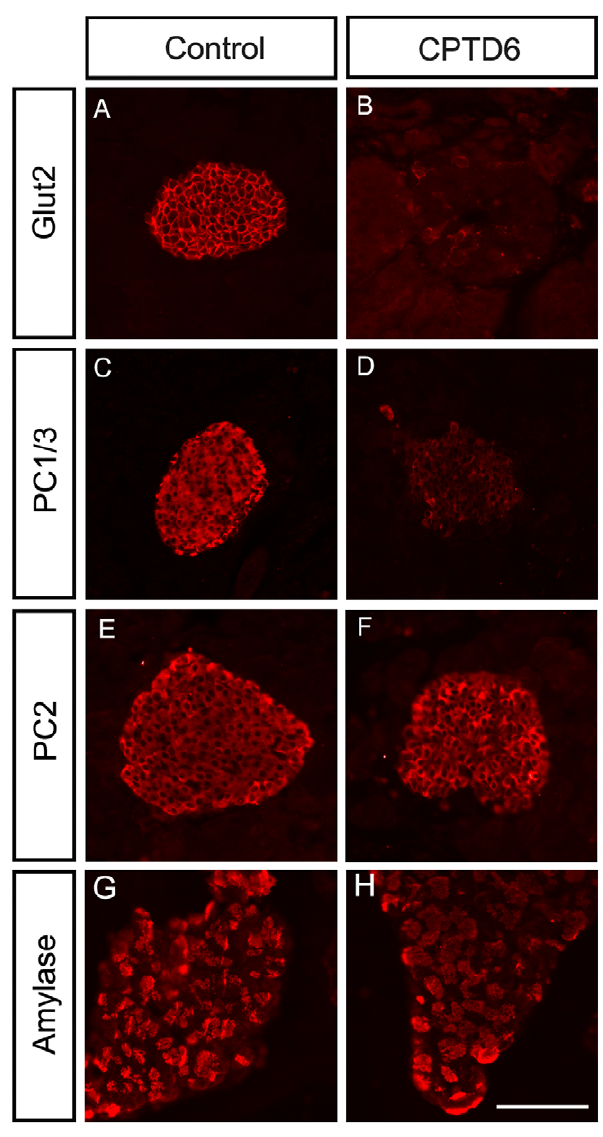
Figure 5. Glucose sensing, hormone processing and the exocrine compartment. ( A , B ) Expression of the glucose transporter Glut2 (Slc2a2), localised at the endocrine cell surface, is lost in CPTD6 mice. ( C, D ) Cytoplasmic expression of the prohormone processing factor PC1/3 (Pcsk1) is absent in CPTD6 mice. ( E , F ). Expression of the processing factor PC2 (Pcsk2) and ( G, H ) the exocrine enzyme amylase are not affected.